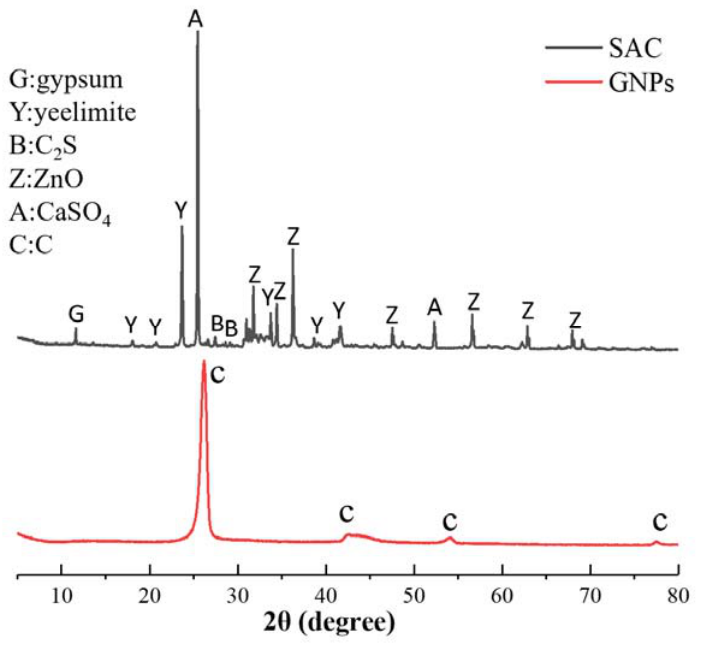
Figure 1. XRD pattern of SAC and GNPs.